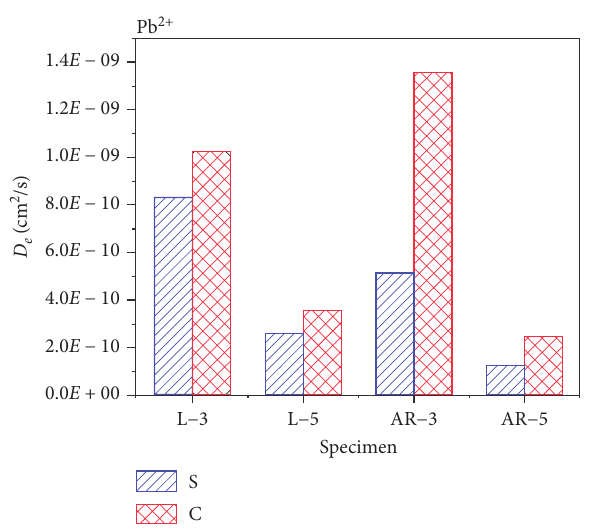
Figure 10: Effective diffusion coefficient of Ca 2+ .